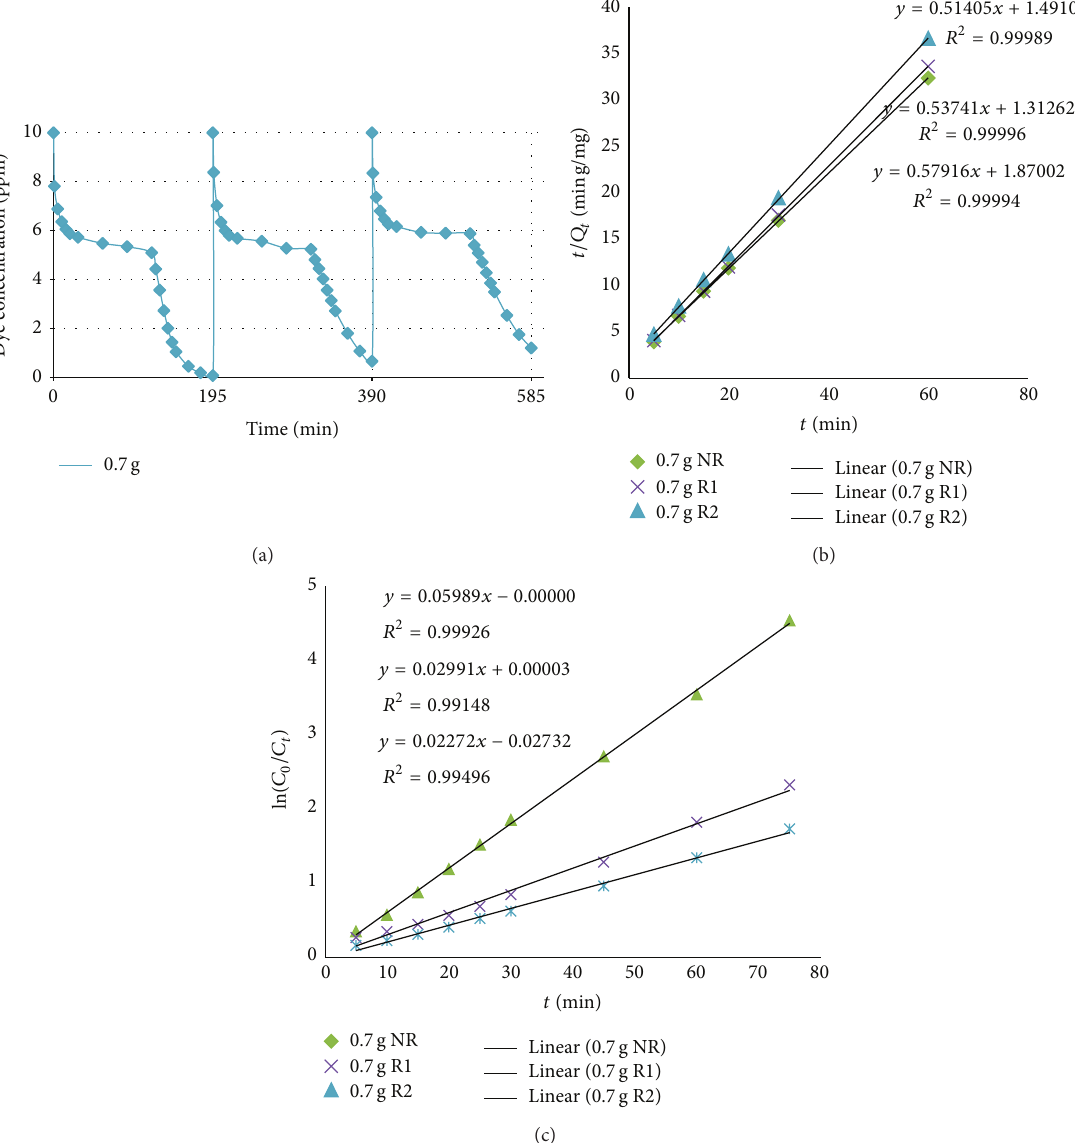
Figure 14: Multicycle MO adsorption-photodegradation curves of experiments with various